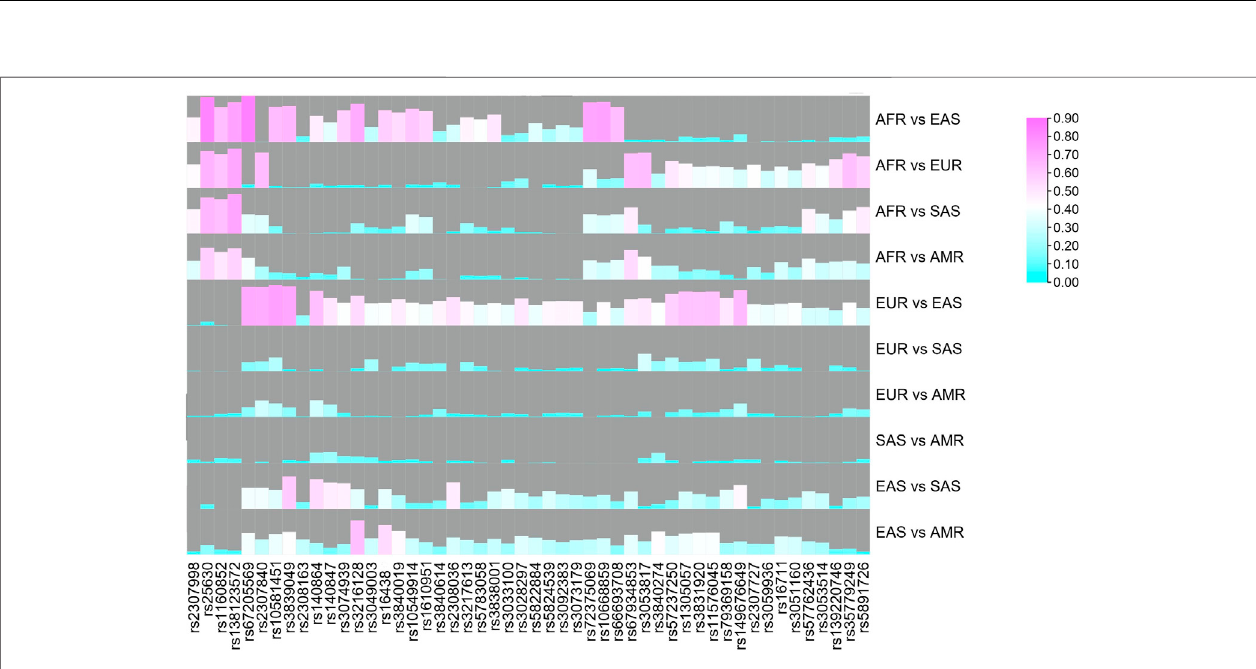
FIGURE 3 | Pairwise F ST values of fi ve continental populations for 50 ancestry informative